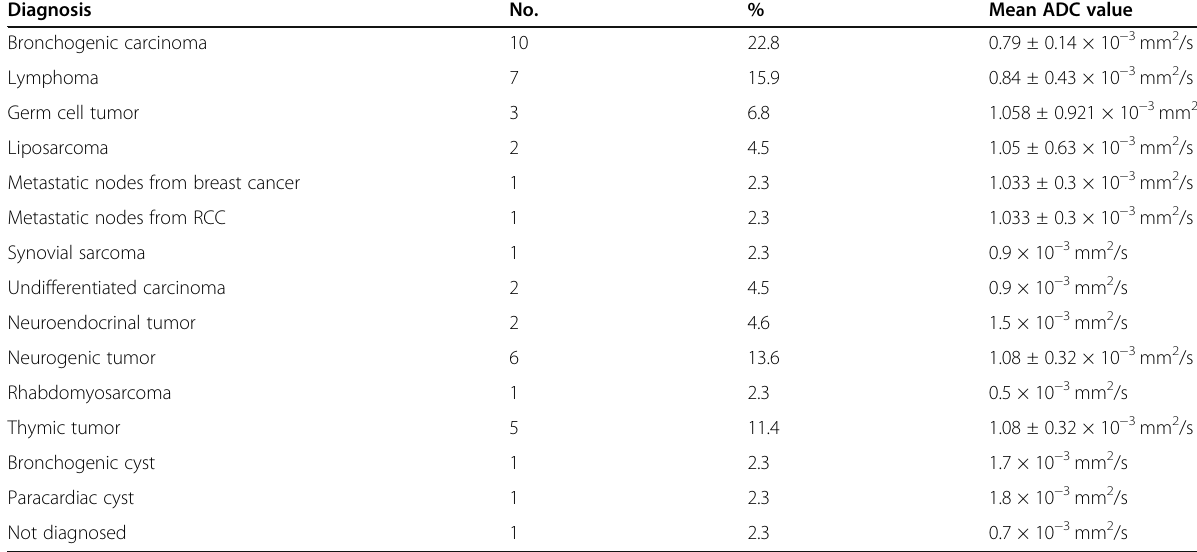
Table 2 Pathological findings and their mean ADC values Diagnosis No.